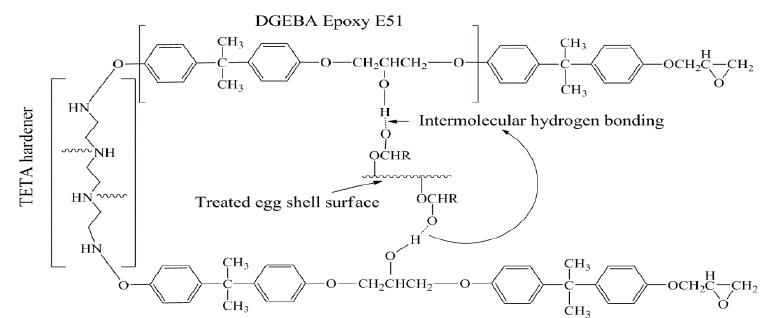
Table 5. DMA data and effectiveness coefficient C of neat epoxy; UES and TES filled epoxy composite. Sample Storage Modulus